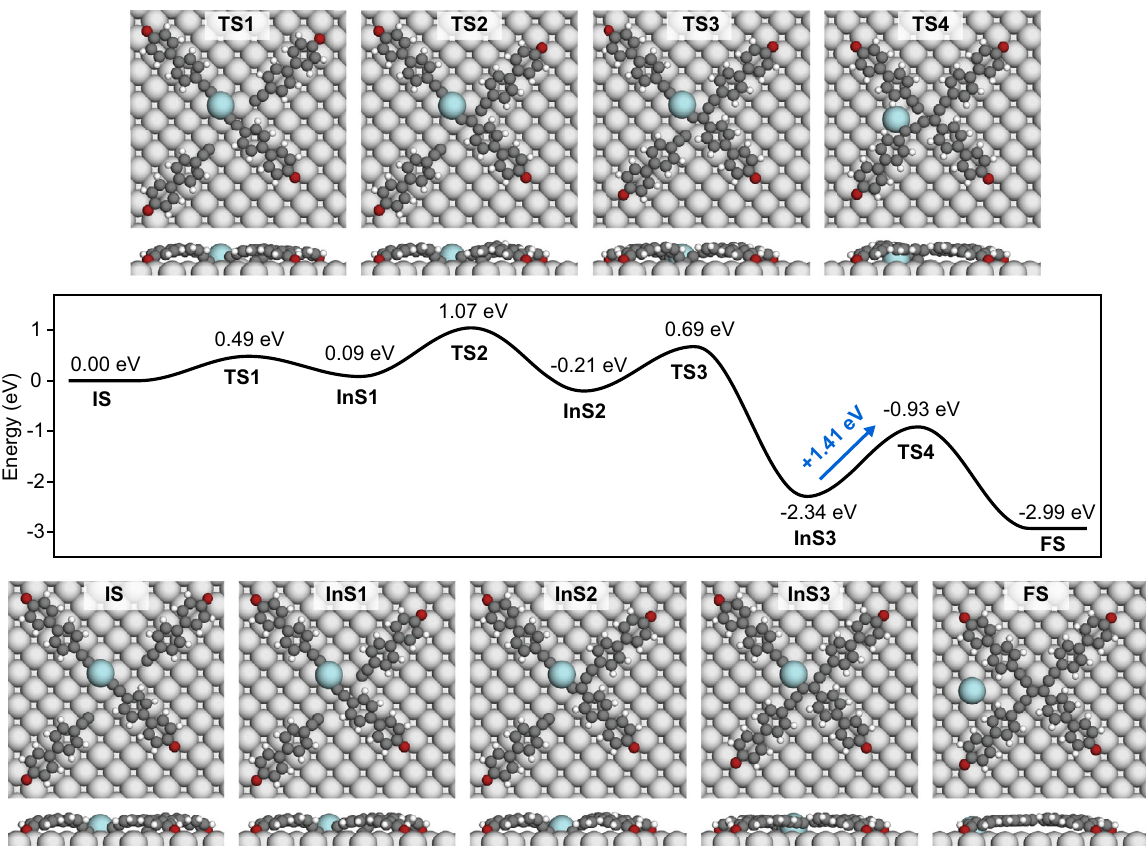
Fig.6|Reactionpathwayandenergypro fi lefromorganometallicdimerstowardtheformationofenetriynederivativesonAg(100). C,H,O,surfaceAgatom,andAg adatom are represented by the dark gray, white, red, light gray, and cyan balls, respectively. Source data are provided as a Source data fi le.